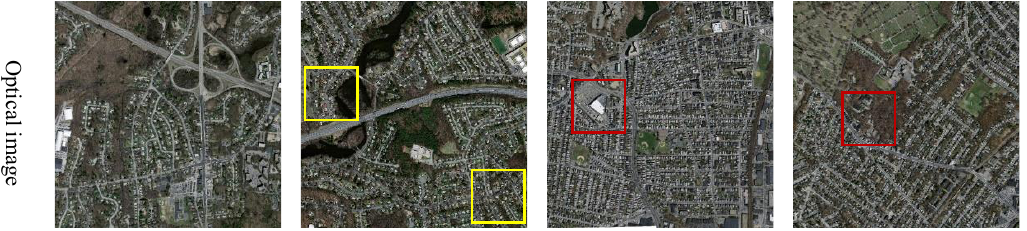
rows and four columns. The columns are images and results for four representative samples in the test dataset. The first to the third rows are the optical image, the ground truth image, and the predicted map of the proposed